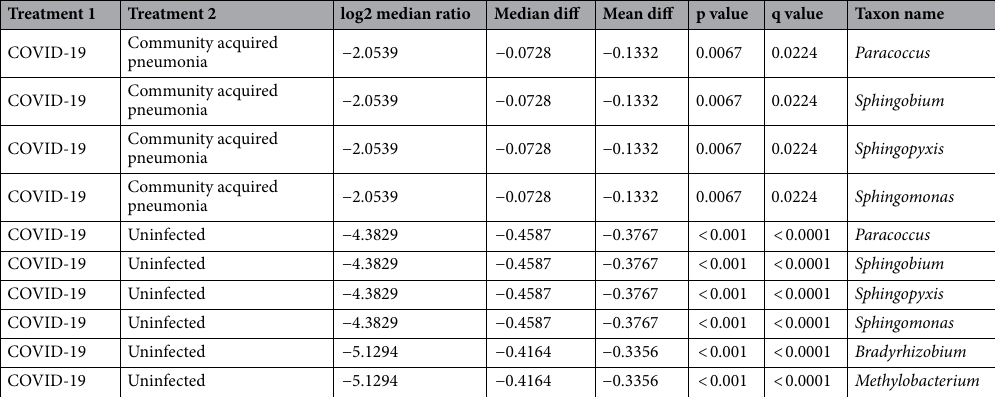
Table 4. Log2 median ratio values of top taxa associated with COVID-19 (n = 29) compared to community acquired pneumonia (n = 25) and uninfected (n = 32) cohorts. Values depicted in the table are mean values at the genus level for taxa that containing > 10 species level significant comparisons with a qvalue < 0.05 and an absolute value of log2 median ratio > 1.0 using Wilcoxon rank sum test adjusted for multiple test comparison. A full list of significant taxonomic comparison values at the species level can be found in Supplementary Table